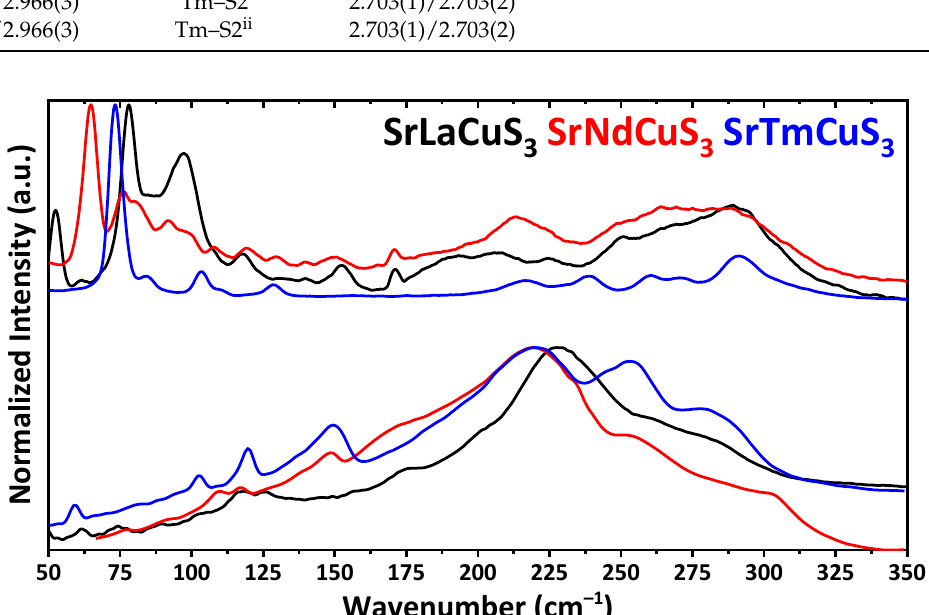
Figure 2. The IR (bottom) and Raman (top) spectra of SrLnCuS 3 (Ln = Sr, Nd, Tm).